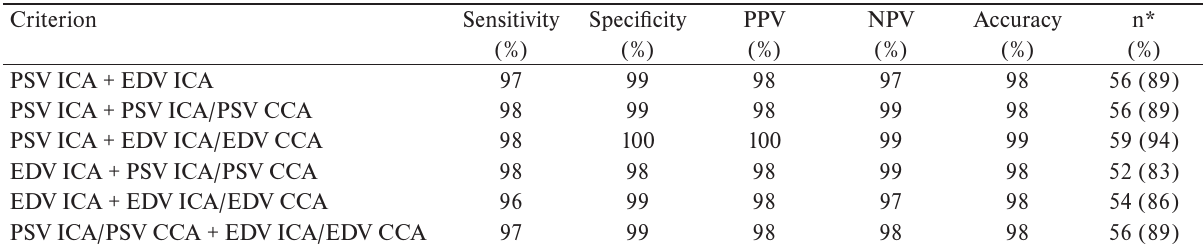
Table 2. Combined velocity criteria for determination of ≥70% stenosis.